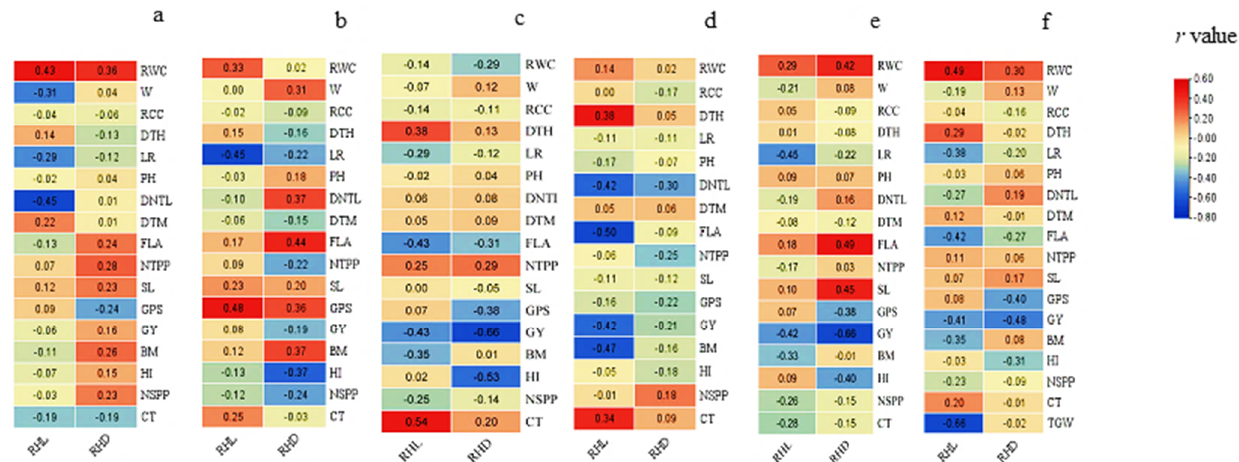
Figure 1. Pearson’s coefficient of correlation between morpho-physiological traits and root hair length (RHL) and root hair density in five different environments including NARC2017 ( a ), NARC2018 ( b ), BARI2017 ( c ), BARI2017D ( d ) BARI2018D ( e ), and their bi linear unbiased predictions (BLUPs) ( f ). Trait abbreviations can be read as: RWC: relative water contents, W: waxiness,